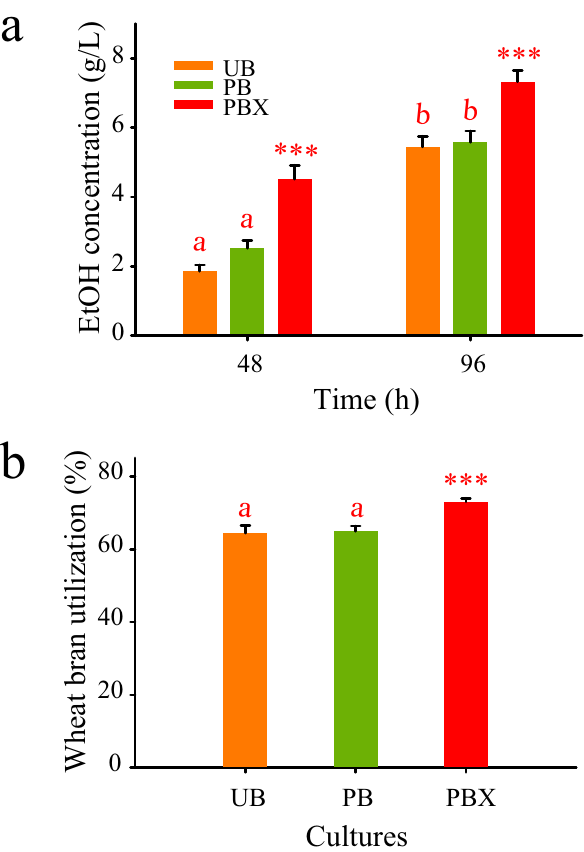
Figure 5. ( a ) Bioethanol production by B. subtilis AP using untreated wheat bran (UB), pretreated wheat bran (PB), and pretreated wheat bran plus Xyn-2 (PBX ) in 2YT medium. Pretreatment was conducted with artificial seawater plus 0.3% HCl. Xyn-2 was included in the PBX culture medium at 13.5 U/mL. ( b ) Wheat bran dissolution efficiency in each culture medium was estimated from the residual biomass at the end of fermentation. The significantly different mean values are indicated by stars (p ≤ 0.001). Letters reflect values that are not significantly different from each other.